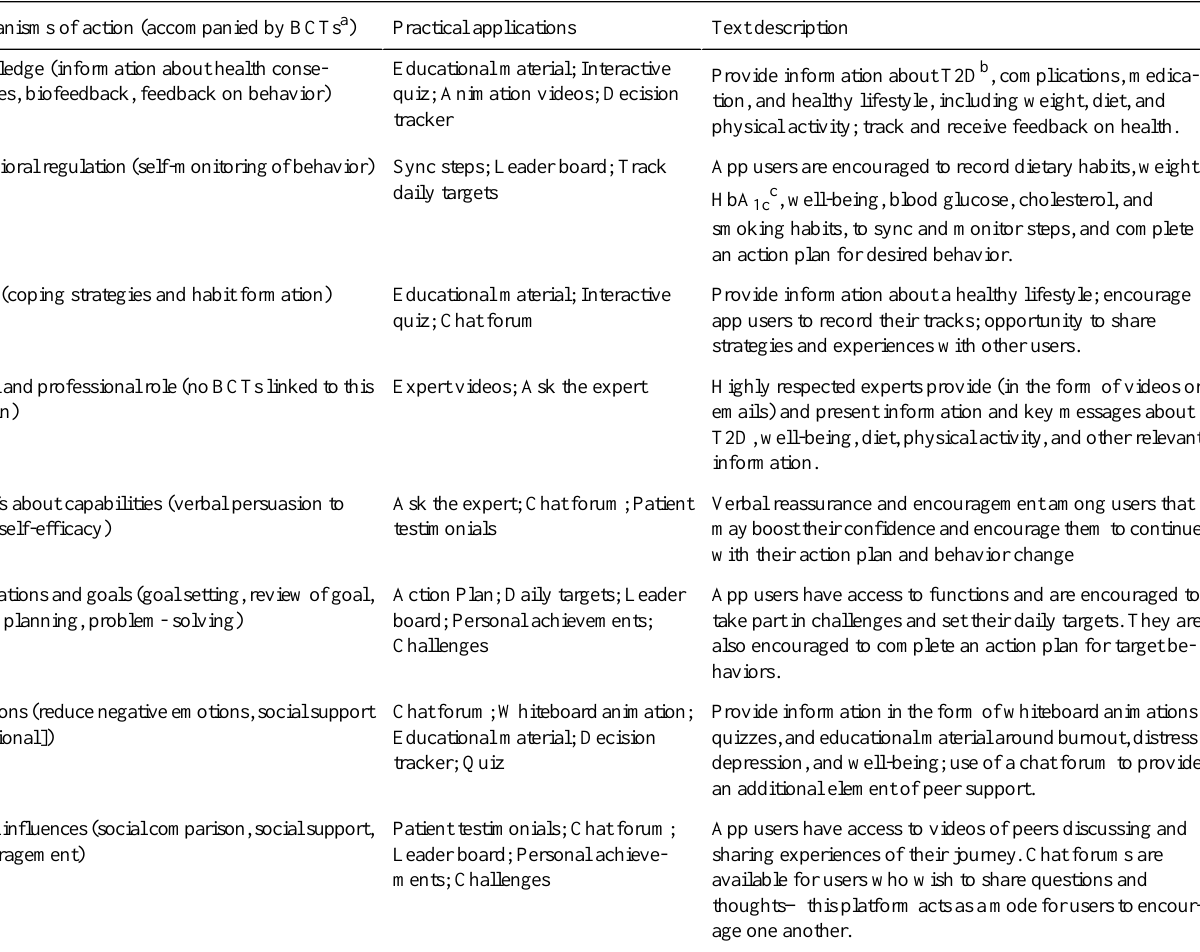
Table 2. Design of practical applications.